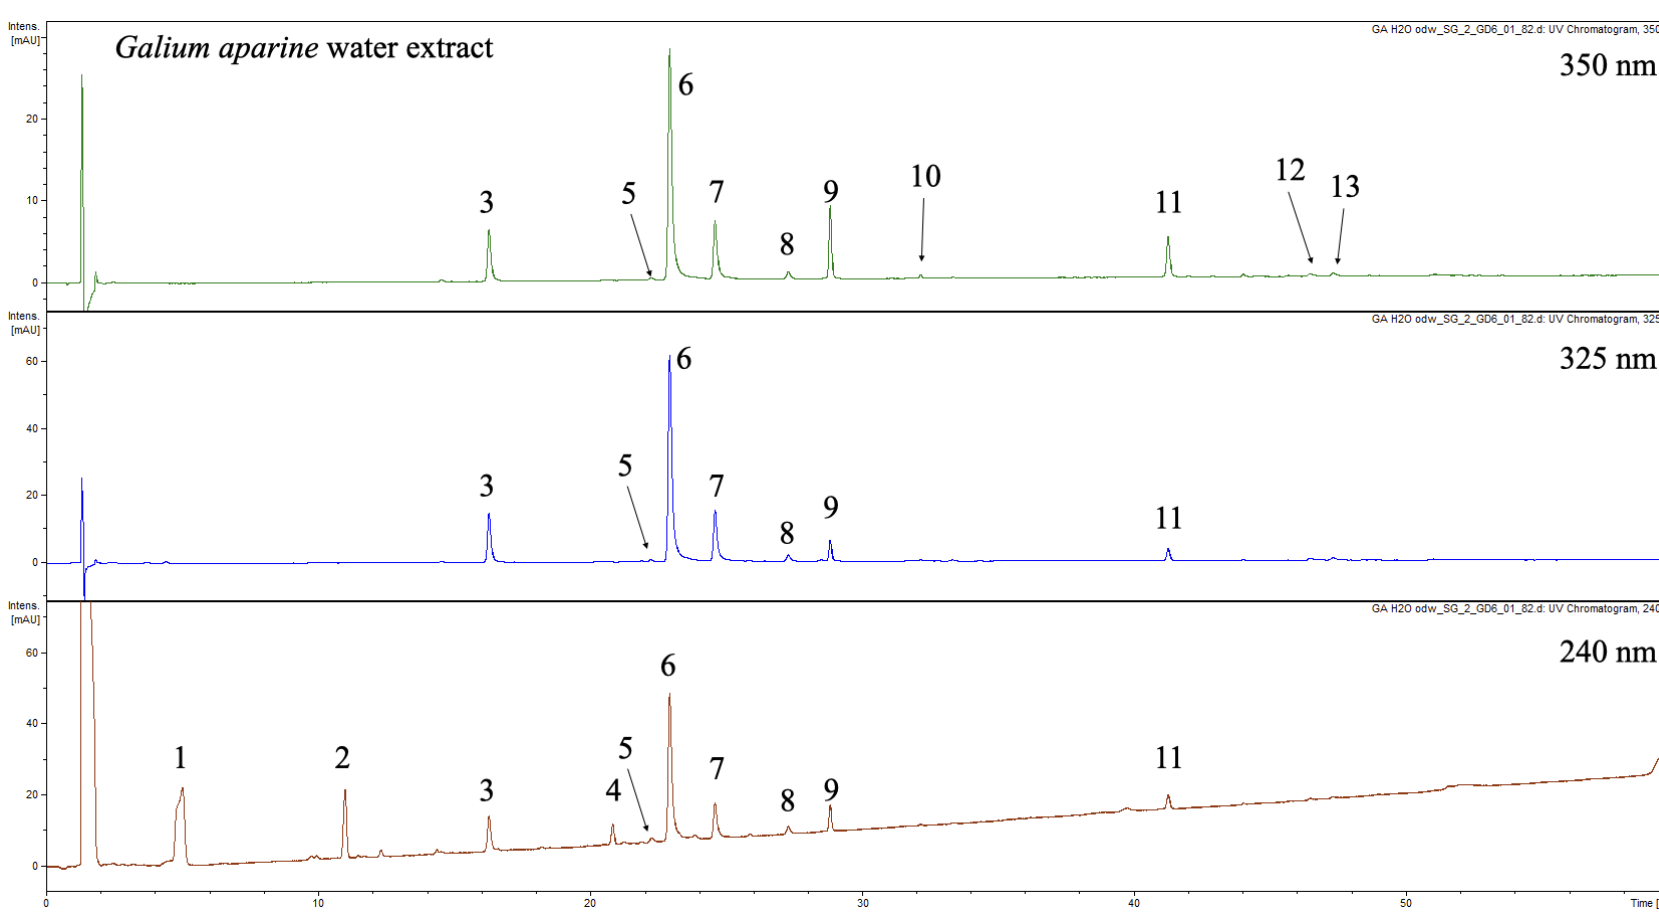
Figure 1. Representative UHPLC-DAD-MS 3 chromatogram at 350, 325 and 240 nm.